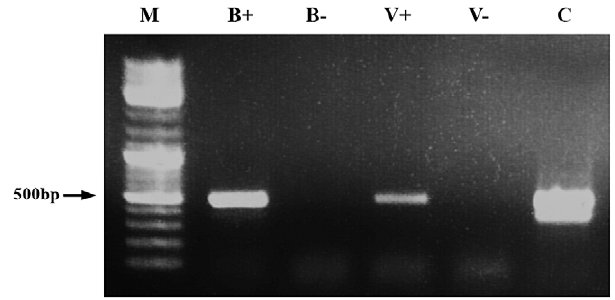
Figure 1. Demonstration of dsRNA transmission from adult bee to Varroa . RT-PCR was performed on RNA extracted from a bee that had ingested dsRNA-GFP (B + ) and from an untreated bee (B 2 ). V + and V 2 represent amplification of RNA extracted from Varroa parasitizing dsRNA-GFP-treated bees and untreated bees, respectively. M=size markers. C=positive control (GFP-carrying